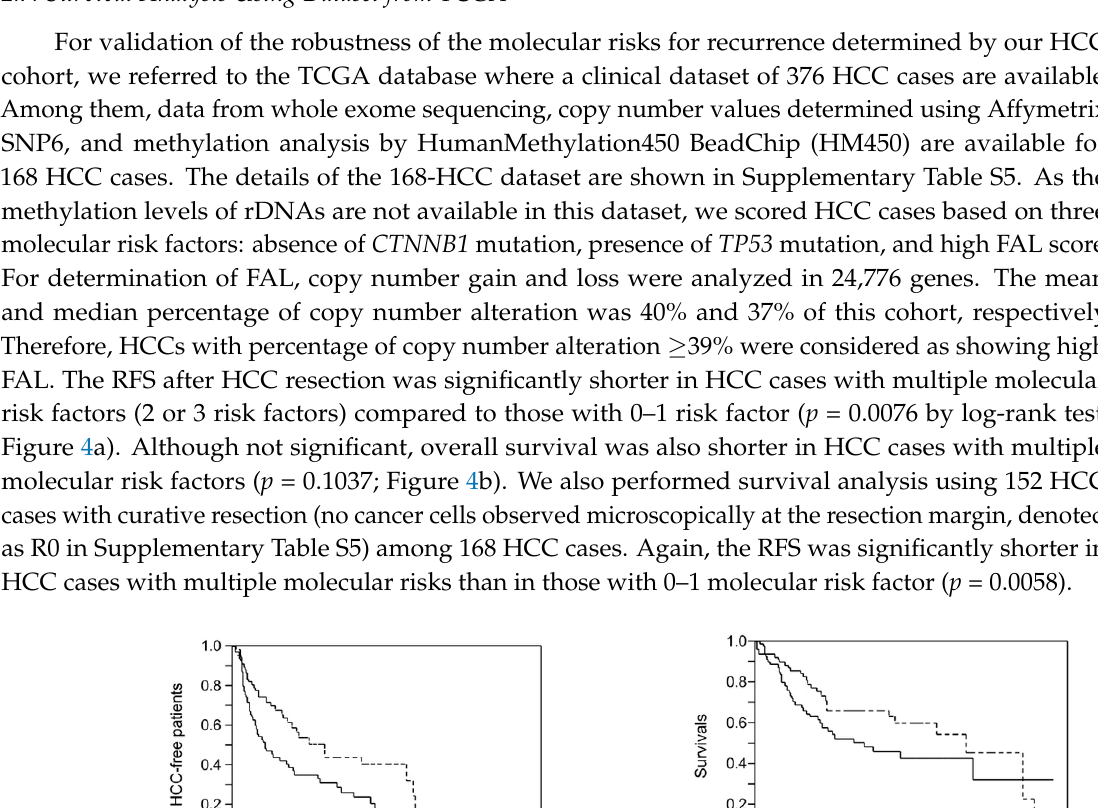
Figure 3 . Recurrence-free survival of HCC patients who underwent liver transplantation. The solid line represents the survival of cases with the aggressive molecular pattern (molecular risk factors ≥ 3), and the broken line represents the cases with mild molecular pattern (molecular risk factors ≤ 2). p = 0.0090 by log-rank test.